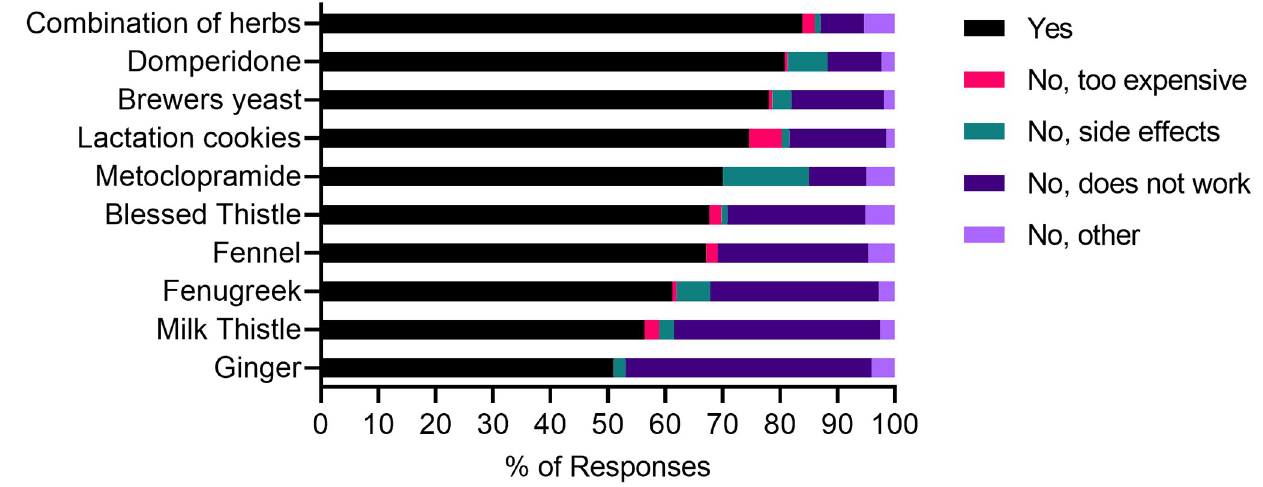
Fig 5. Women’s recommendations of galactagogues to a friend and their reasons for not recommending.